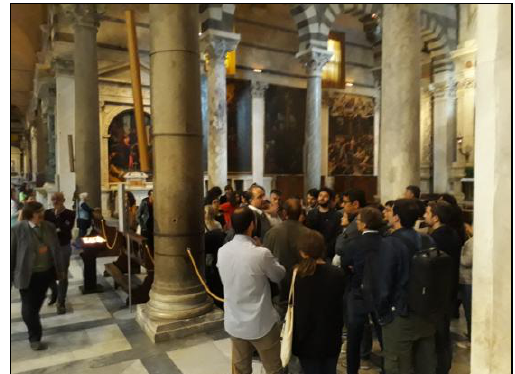
Figure 2. Preparation of the laser scan phase into the